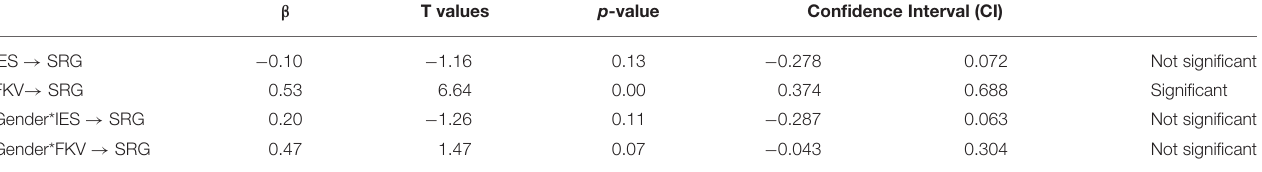
TABLE 4 | Indirect effect results.